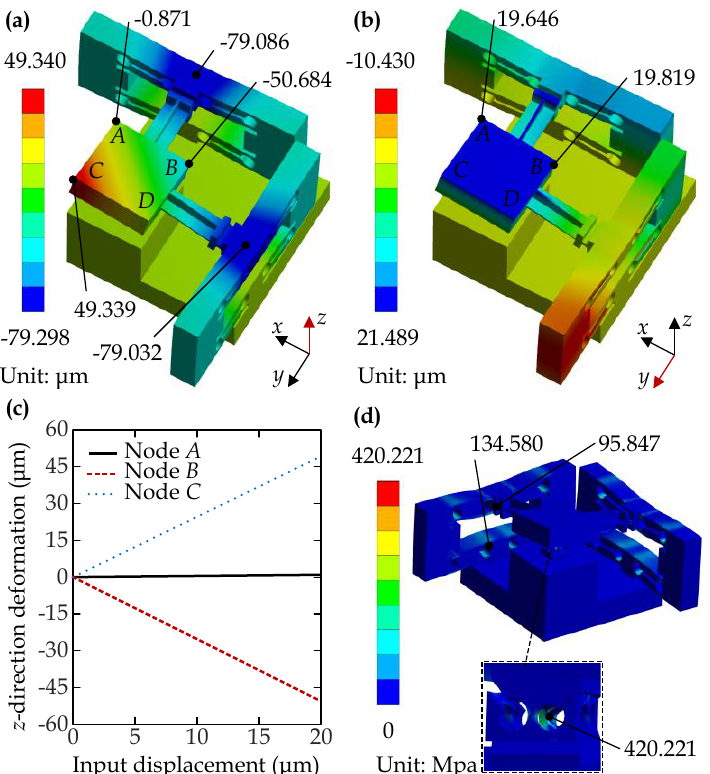
Figure 6. Static performance results in two-axis actuation without load. ( a ) z -direction deformation in x and y -axis actuation. ( b ) y -direction deformation in x and y -axis actuation. ( c ) z -direction deformation of nodes A and B in x and y -axis actuation. ( d ) Stress distribution in x and y -axis